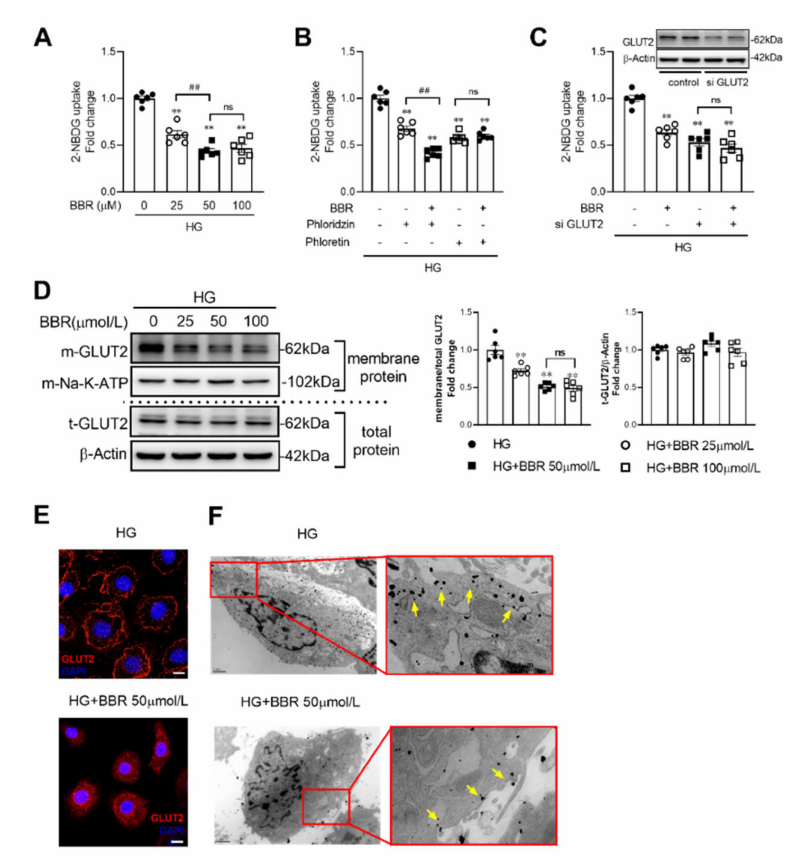
Figure 3. Berberine decreased glucose absorption in a dose-dependent manner through inhibiting GLUT2 translocation in IEC-6 cells. ( A ) Berberine decreased 2-NBDG uptake in a dose-dependent manner in IEC-6 cells. ( B , C ) phloretin, a GLUT2 inhibitor, rather than phloridzin, a SGLT1 inhibitor, blocked berberine’s effects on 2-NBDG uptake in IEC-6 cells. ( D ) siRNA for GLUT2 blocked berber- ine’s effects on cellular 2-NBDG uptake in IEC-6 cells. ( E ) GLUT2 (red fluorescence) in BBM was decreased berberine treated (50 µ M) for 2 h, bar = 20 µ m, blue fluorescence (DAPI) represented for cell nucleus. ( F ) Electron micrographs showed that GLUT2 positive gold particles at membrane were decreased in IEC-6 cells after berberine treatment (50 µ M) for 2 h, bar = 1 µ m under low power lens; bar = 400 nm under high power lens. HG, high concentration of glucose (50 mM); phloretin (0.5 mM), GLUT2 inhibitor; phloridzin (0.5 mM), SGLT1 inhibitor; si GLUT2, siRNA for GLUT2; Data are expressed as mean ± SEM ( n = 6). m-Na-K-ATP was used as internal reference of the membrane. ** p < 0.01, vs. control; ## p < 0.01; ns, no